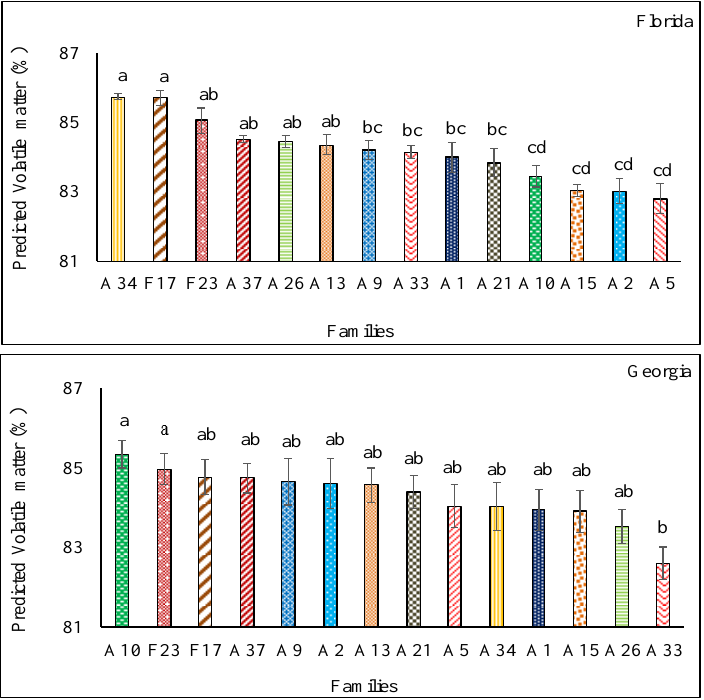
Figure 2. Rank of loblolly pine families for volatile matter content. * Bars with different letters are significantly different at 95% confidence level (Tukey’s HSD Test).